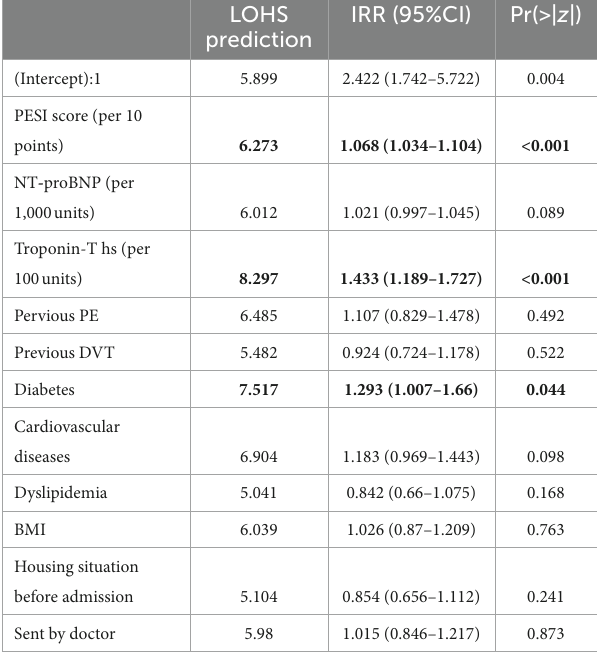
TABLE 2 Results of multivariable zero-truncated negative binomial regression model for length of hospital stay (LOHS) estimation in pulmonary embolism survivors ( n =